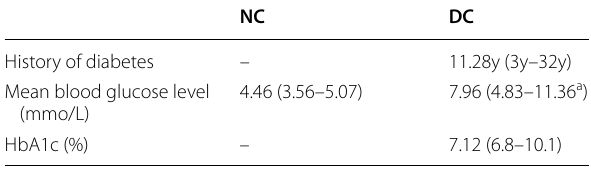
Table 1 The history (length) of diabetes, mean glucose and HbA1c of the patients